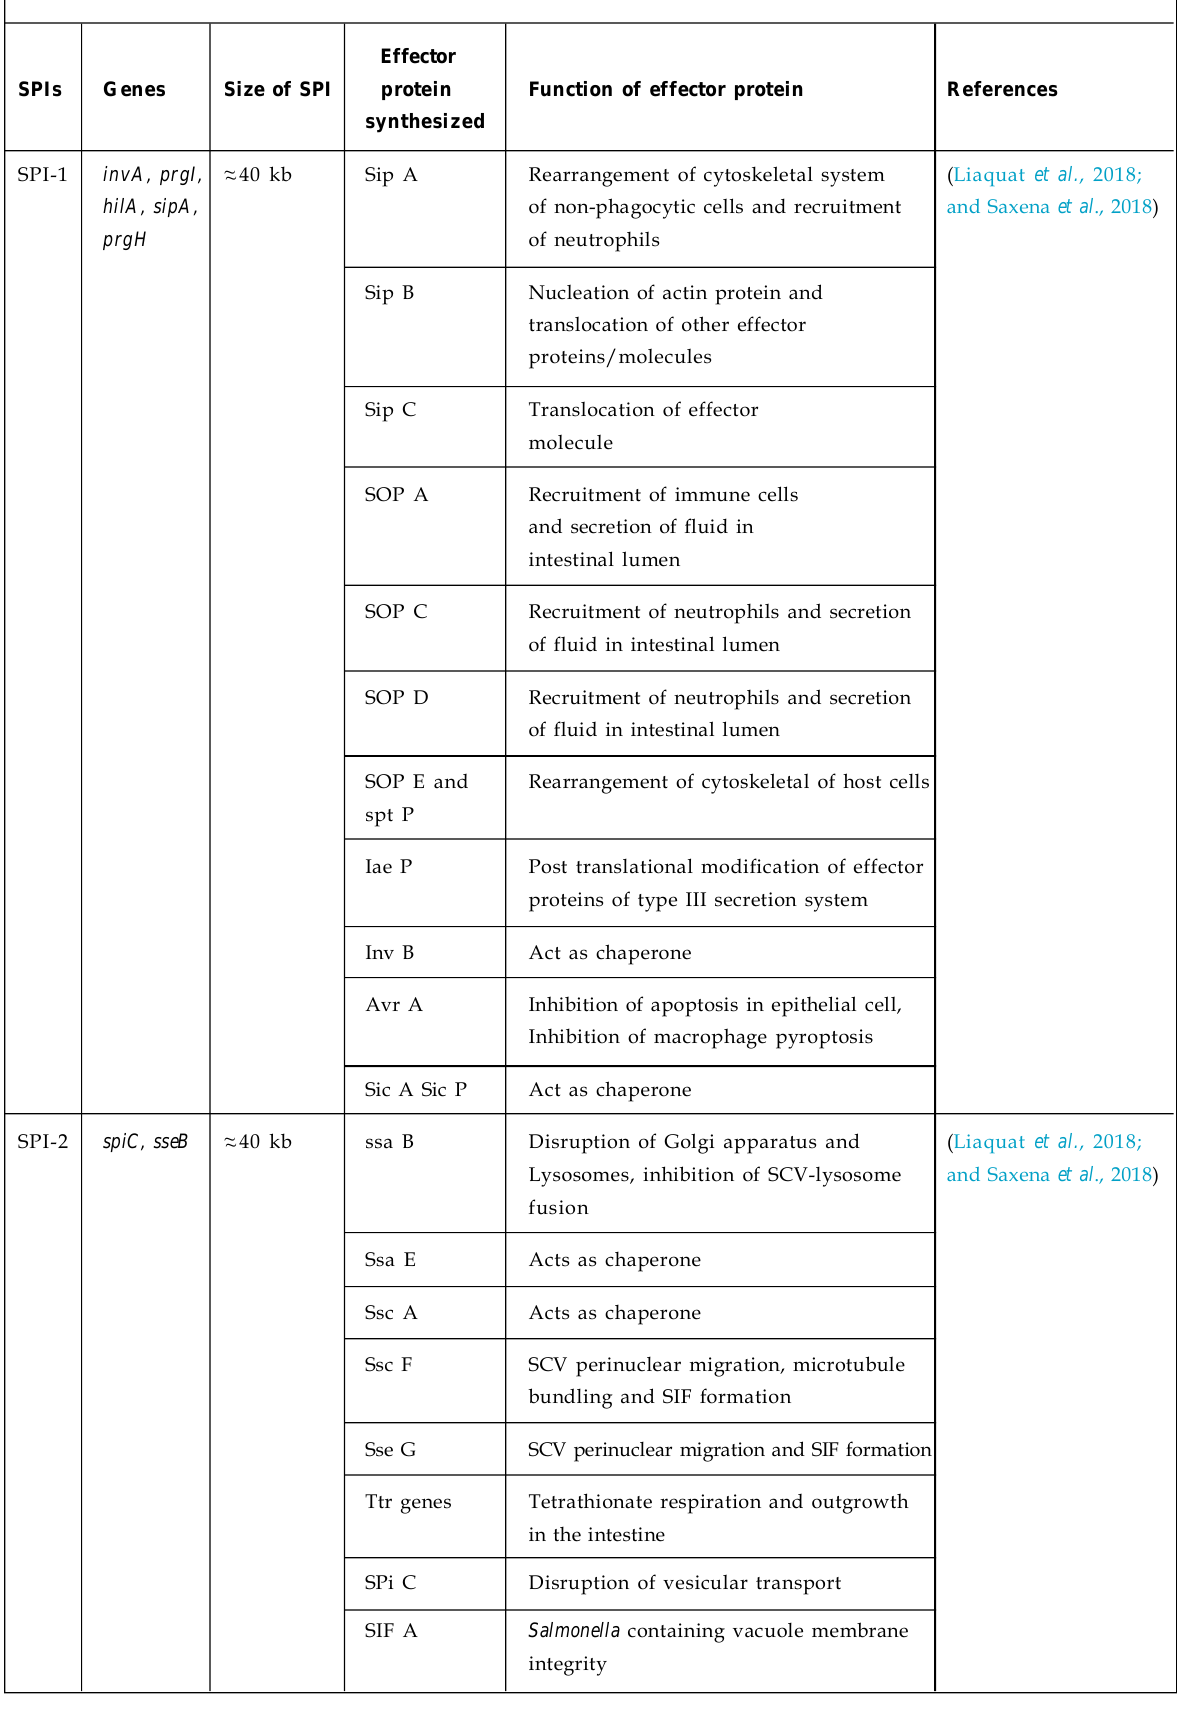
Table 1: Salmonella Pathogenicity Islands (SPI), genes on SPI and size of SPI, effector protein and their